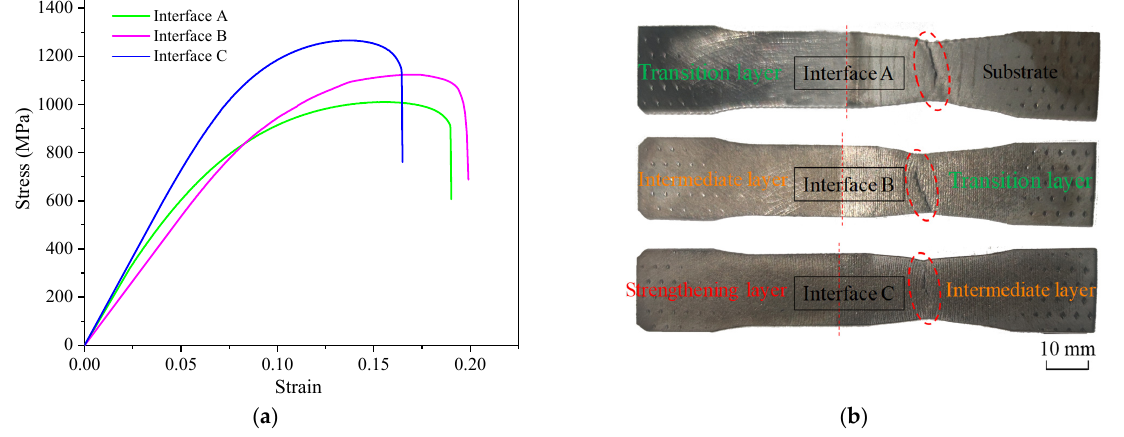
Figure 11. Bonding strength of gradient interfaces. ( a ) Stress–strain curves of the tensile specimens. ( b ) Image of fracture specimens after tensile test. The red circle outlines the location of the fracture. Table 5. Tensile properties of gradient inte r faces.